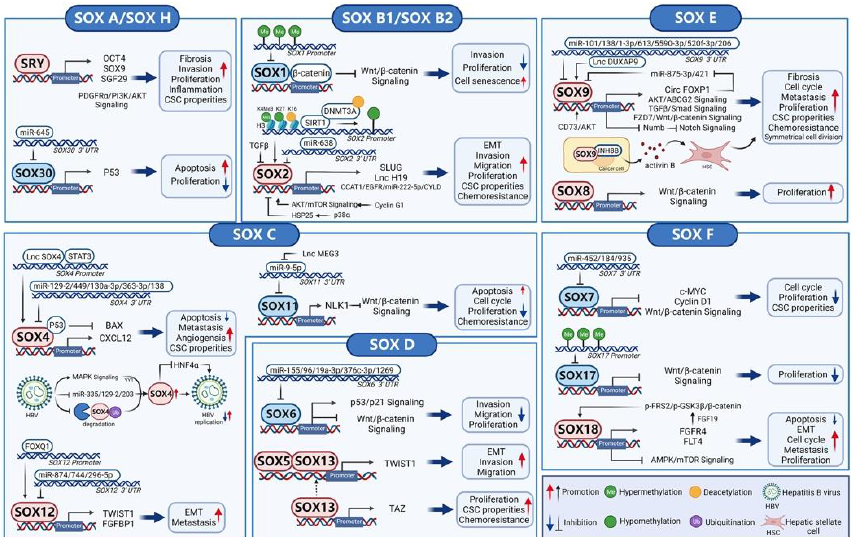
Figure 2. The roles and molecular mechanisms of SOX transcription factors in hepatocellular carcinoma (HCC). SOX members serve as master tumor drivers or suppressors to transcriptionally regulate key downstream targets or signaling pathways, therefore controlling the initiation and progression of HCC. Simultaneously, the dysregulated SOX expression is frequently observed in HCC, which is mainly attributed to promoter hypermethylation, signaling pathway regulation, and post-transcriptional modulation by miRNAs (microRNAs). This diagram was created by BioRender.com (accessed on: 28 November 2021). The red box represents tumor driver, and the blue box represents tumor suppressor. Abbreviations: SOX: Sex-determining region Y-related high-mobility group box; SRY: Sex-determining region Y; CSC: Cancer stem cell; 3′UTR: 3′ untranslated region; H3: Histone 3; EMT: Epithelial-mesenchymal transition.